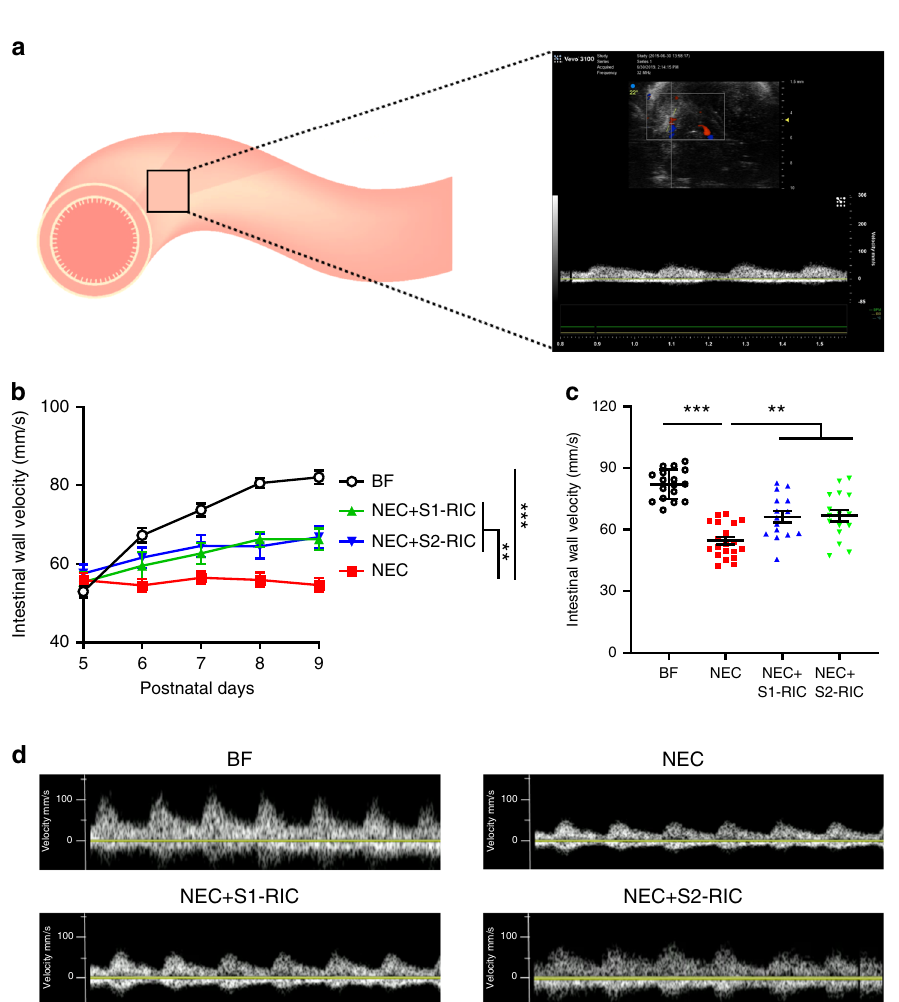
Fig. 3 RIC improves intestinal wall perfusion during NEC development. a Intestinal wall perfusion was measured using Doppler ultrasound and calculated as average fl ow velocity (mm/s) of multiple abdominal regions. b Intestinal wall perfusion measured daily from P5 to P9 showed reduced perfusion in NEC pups which was improved following conditioning with Stage 1 or 2 RIC ( n = 6 per group; minimum of 3 readings of different abdominal quadrants were obtained per pup; ** p < 0.01; *** p < 0.001). c Intestinal wall perfusion measured on P9 in NEC pups showed reduced perfusion compared to breastfed (BF) control, which was preserved in NEC pups receiving Stage 1 or 2 RIC ( n = 6 per group; minimum of 2 readings of different abdominal quadrants were obtained per pup; ** p < 0.01; *** p < 0.001). d Representative images of arterial waves obtained with the Doppler ultrasound in P9 pups from listed groups. Data were compared using two-sided one-way ANOVA with post hoc Turkey test and data are presented as mean ± SEM. Source data are provided as a Source Data fi